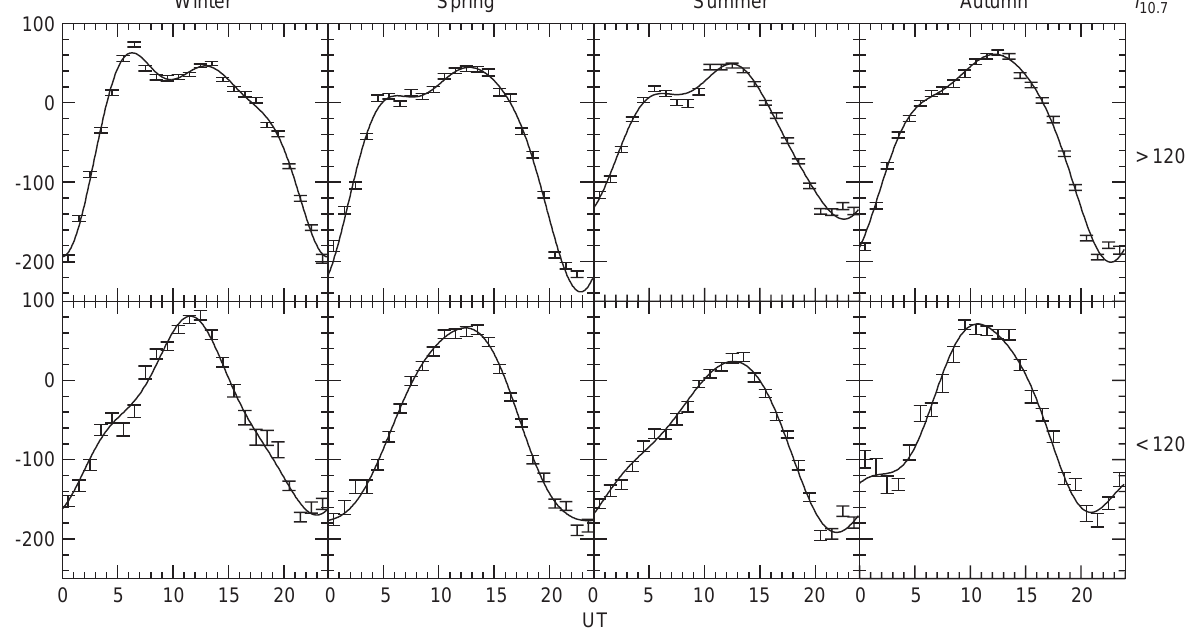
second to low solar fluxes. From left to right one can see winter, spring, summer, and